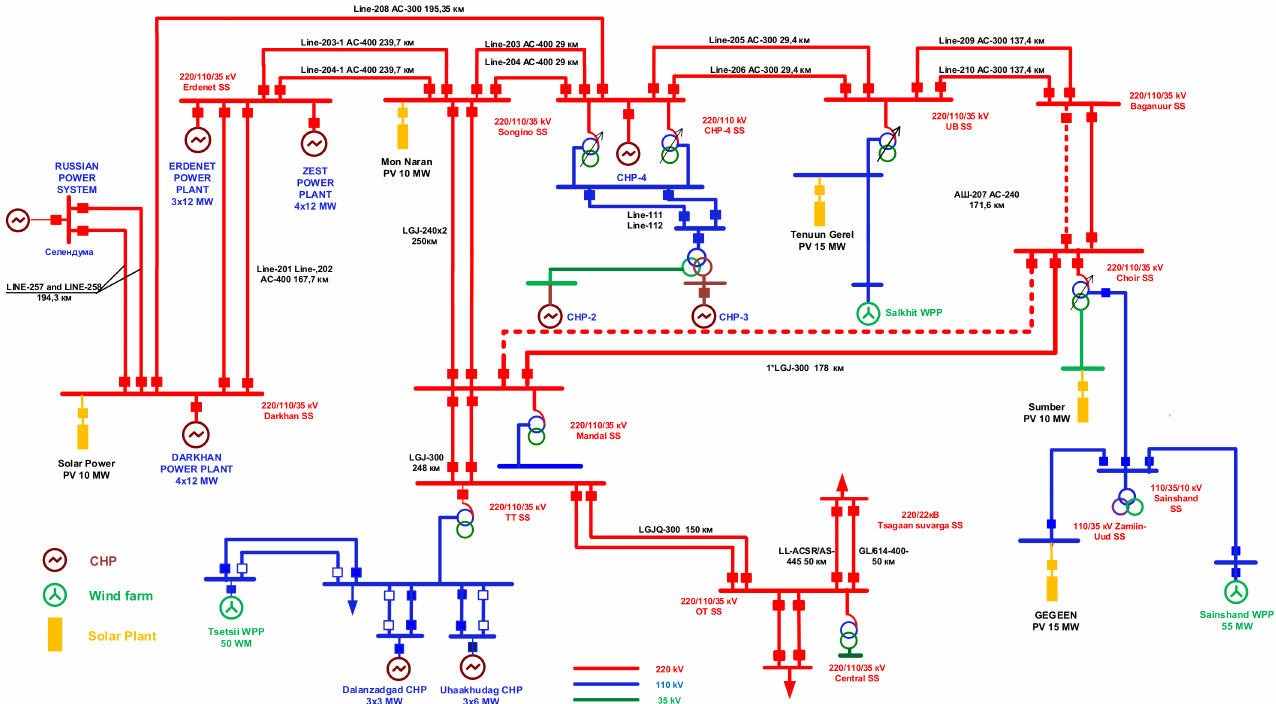
Figure 7. Single line diagram of existing power plants and transmission